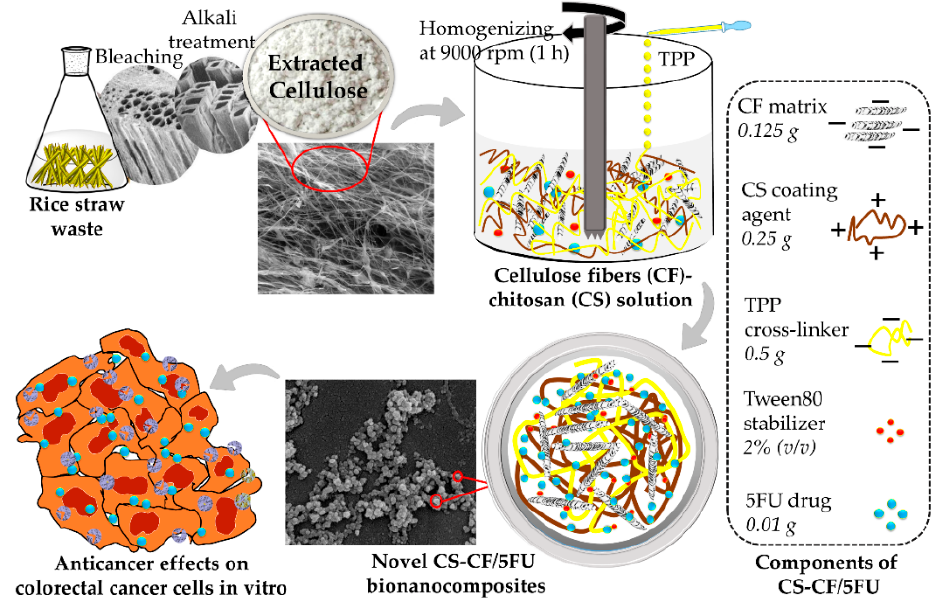
Scheme 1. A schematic process of synthesis of CS-CF/5FU BNCs for in vitro cytotoxicity